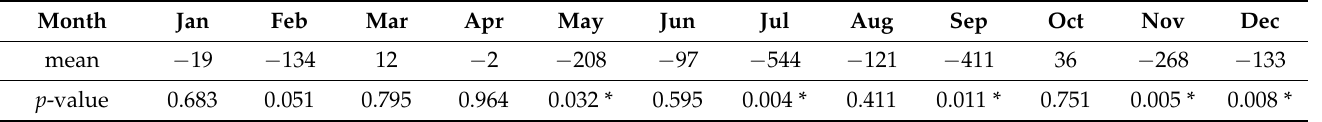
Table 4. Paired sample t -test for months of 2017 and 2018.